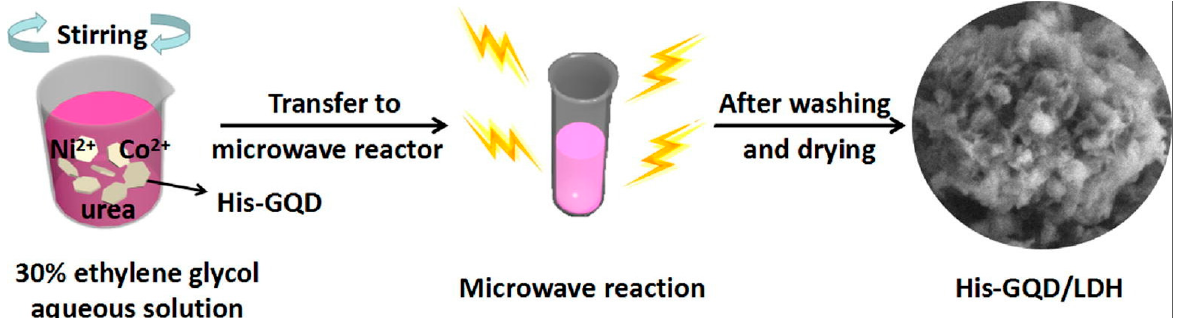
Figure 7. Illustration of the microwave synthesis of graphene quantum dots/Ni-Co LDH. Reprinted with permission from Ref. [65].